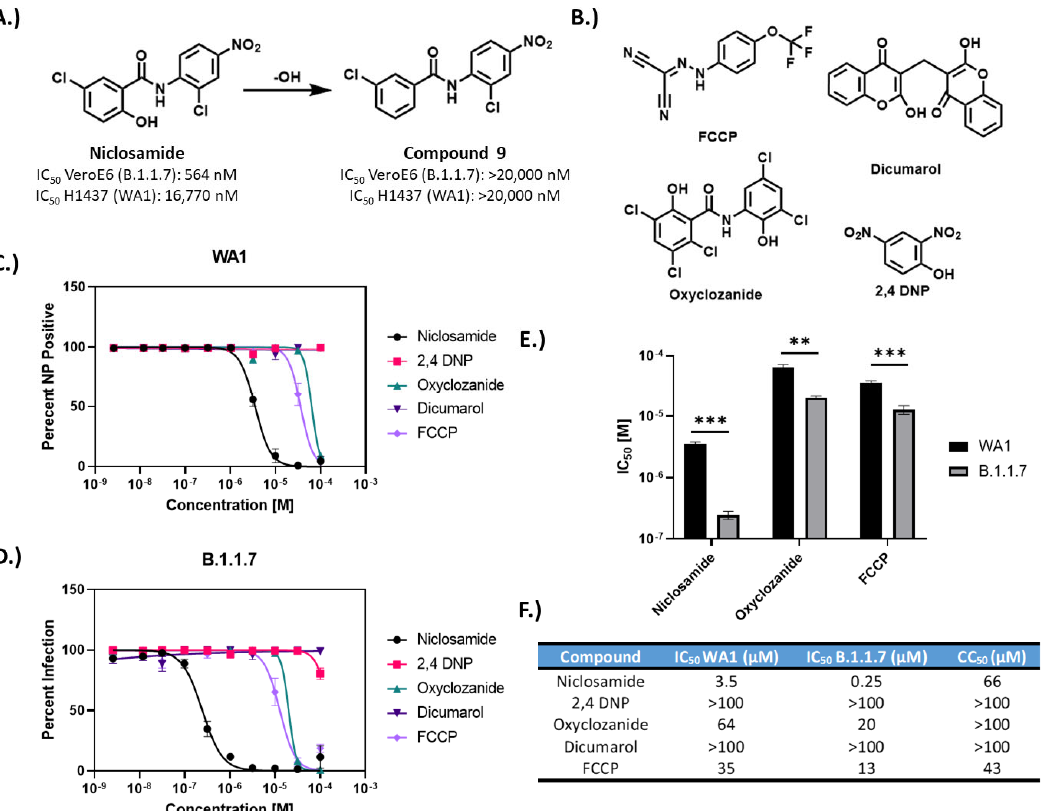
Figure 5. Efficacy of protonophores against SARS-CoV-2. ( A ) Removal of protonophore hydroxyl of niclosamide results in a complete loss of efficacy in both VeroE6 and H1437 cells. ( B ) Chemical structures for other protonophores evaluated against SARS-CoV-2 infection. ( C , D ) 10-point, 2-fold concentration–response curves for protonophores versus WA1 variant ( C ) and B.1.1.7 variant ( D ) with starting concentrations of 100 µ M. ( E ) IC 50 plot for antiviral protonophores indicating significantly different potency against variants. ** = p < 0.01, *** = p < 0.001. ( F ) Table of IC 50 and CC 50 values for protonophores.